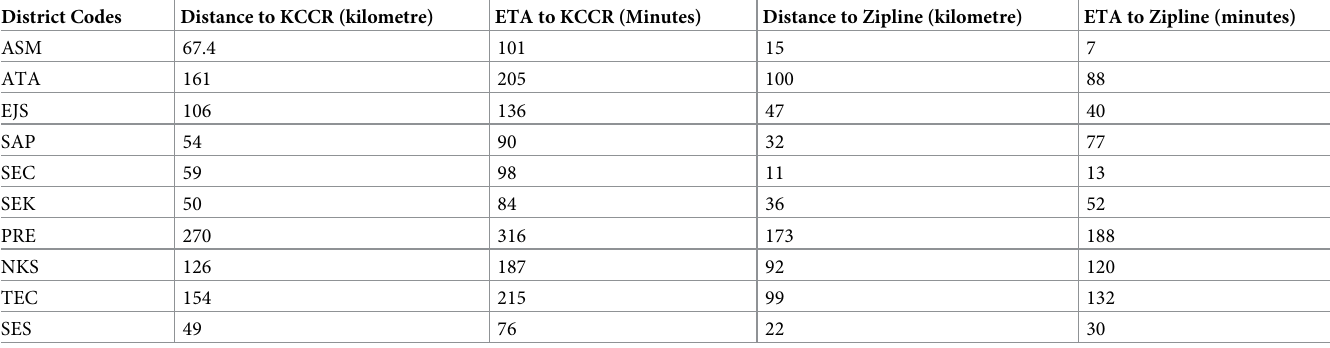
Table 3. Distances covered by districts to the Zipline Mpanya office and to KCCR. District Codes